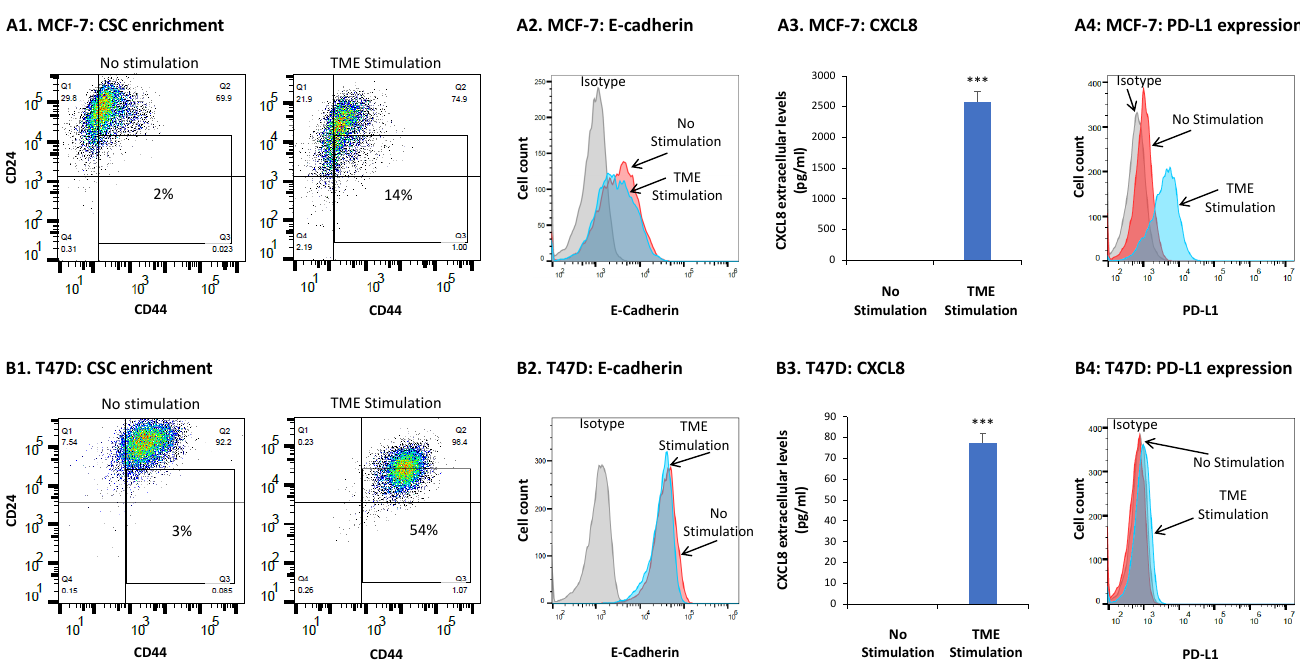
Figure 1. TME Stimulation leads to intrinsic and TME-related pro-metastatic effects in MCF-7 and T47D HR+/HER2 − breast cancer cells: MCF-7 ( A ) and T47D ( B ) HR+/HER2 − human breast tumor cells were exposed to TME Stimulation in culture (estrogen 10 − 8 M, TNF α 50 ng/mL, EGF 30 ng/mL) or to vehicles only (“No stimulation”) for 96 h. The stimulatory conditions were selected following titration and kinetics analyses. Concentrations agree with the conventional dose range used in other research systems [31,44,45]. ( A1 , B1 ) The contents of CSCs, determined as CD44 + /CD24 low/ − cells. Cell surface CD44 and CD24 expression was determined by flow cytometry, using fluorescently- labeled specific antibodies. Isotype-matched control antibodies were used to determine baseline staining (not shown). ( A2 , B2 ) EMT-related properties, manifested by cell surface expression of E- cadherin, were determined by flow cytometry using fluorescently-labeled specific antibodies. Isotype- matched control antibodies were used to determine baseline staining (Isotype). ( A3 , B3 ) CXCL8 expression was determined in the conditioned media (CM) of the cells by ELISA, at the linear range of absorbance. ( A4 , B4 ) Cell surface PD-L1 expression was determined by flow cytometry using fluorescently-labeled specific antibodies. Isotype-matched control antibodies were used to determine baseline staining (Isotype). In all panels, the results are from a representative experiment of n ≥ 3, showing similar results. *** p < 0.005 in MCF-7 cells and p < 0.001 in T47D